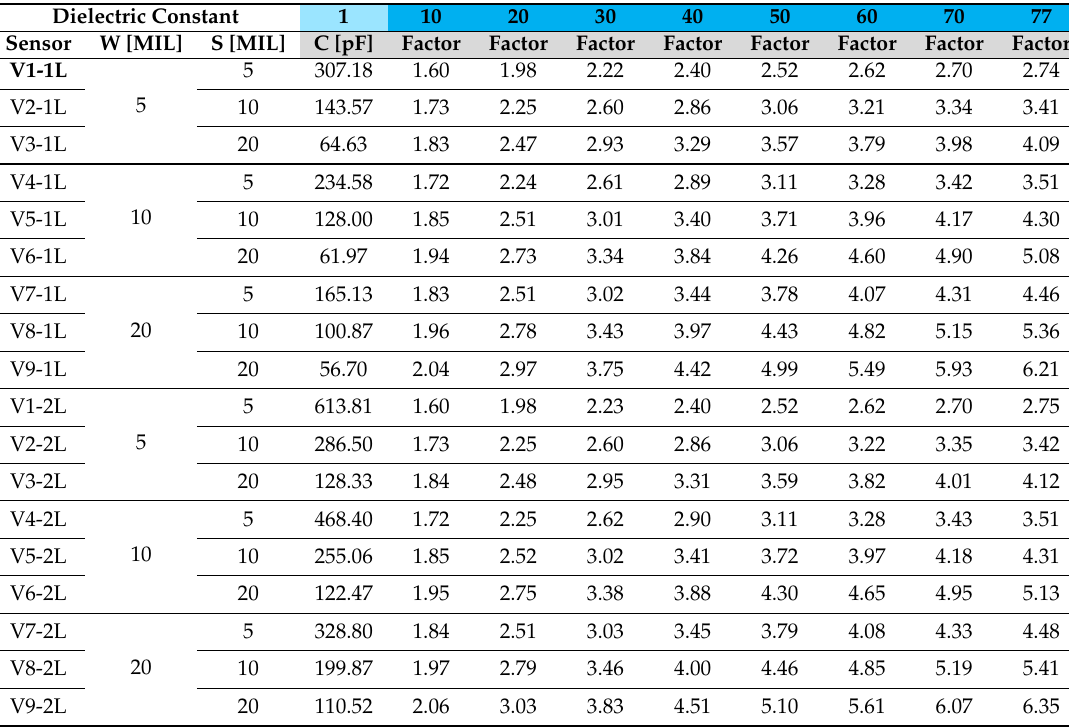
Table 1. Simulation and measurement results for the structures designed on a fixed thickness PCB. The environment is air ( (cid:101) r = 1) or distilled water ( (cid:101) r swept from 10 to 77). Capacitance is listed as absolute value in pF only for air and as increase factor for the rest of the cases.